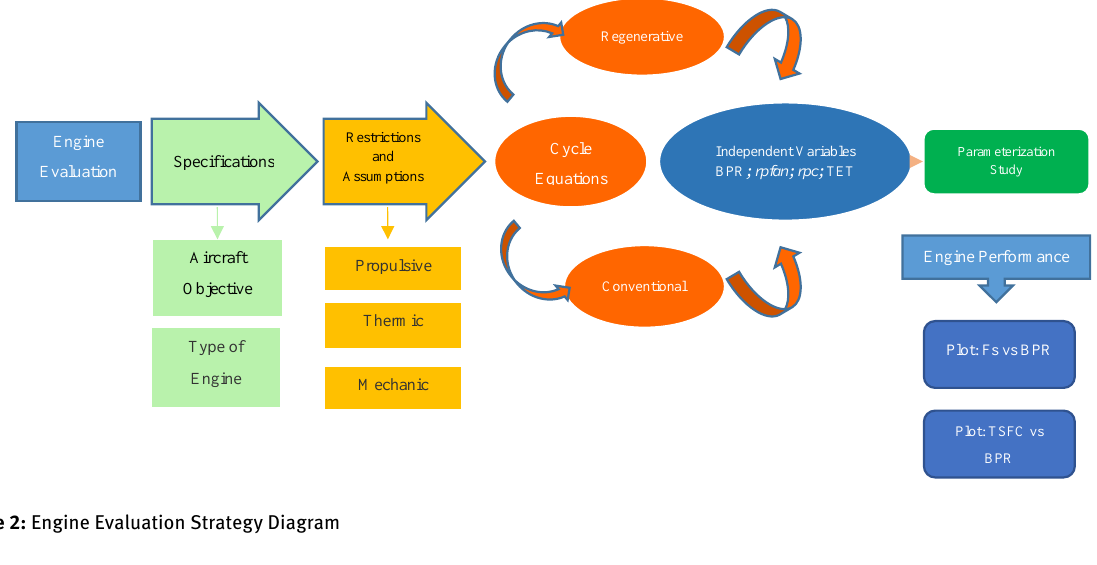
Figure 2: Engine Evaluation Strategy Diagram